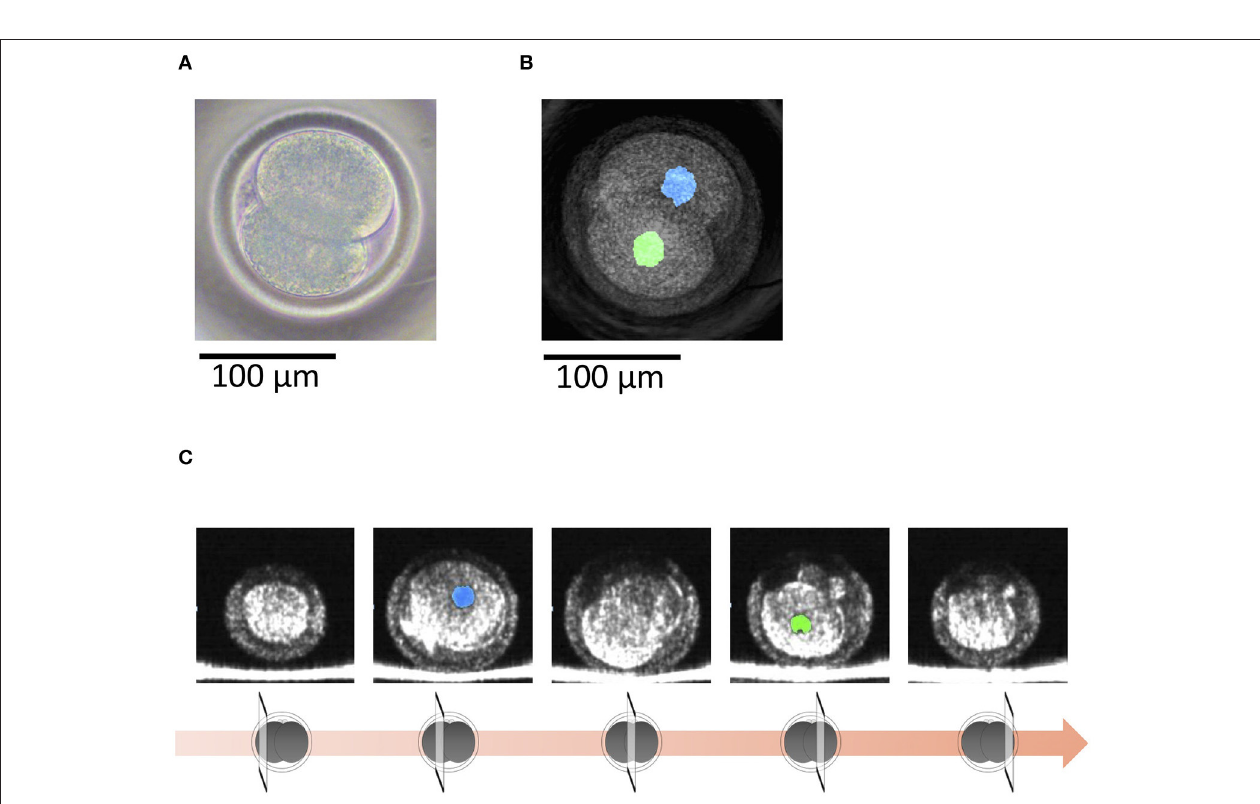
FIGURE 4 | (A) A bovine 2-cell embryo imaged by a microscope. (B) Optical coherence tomography (OCT) images of the bovine 2-cell embryo with visualization of the nucleus (blue and green) of the blastomere. (C) Tomographic images obtained by OCT imaging. Panels are images shifted by 25 µ m from the center of the embryo with visualization of the nucleus (blue and green) of the